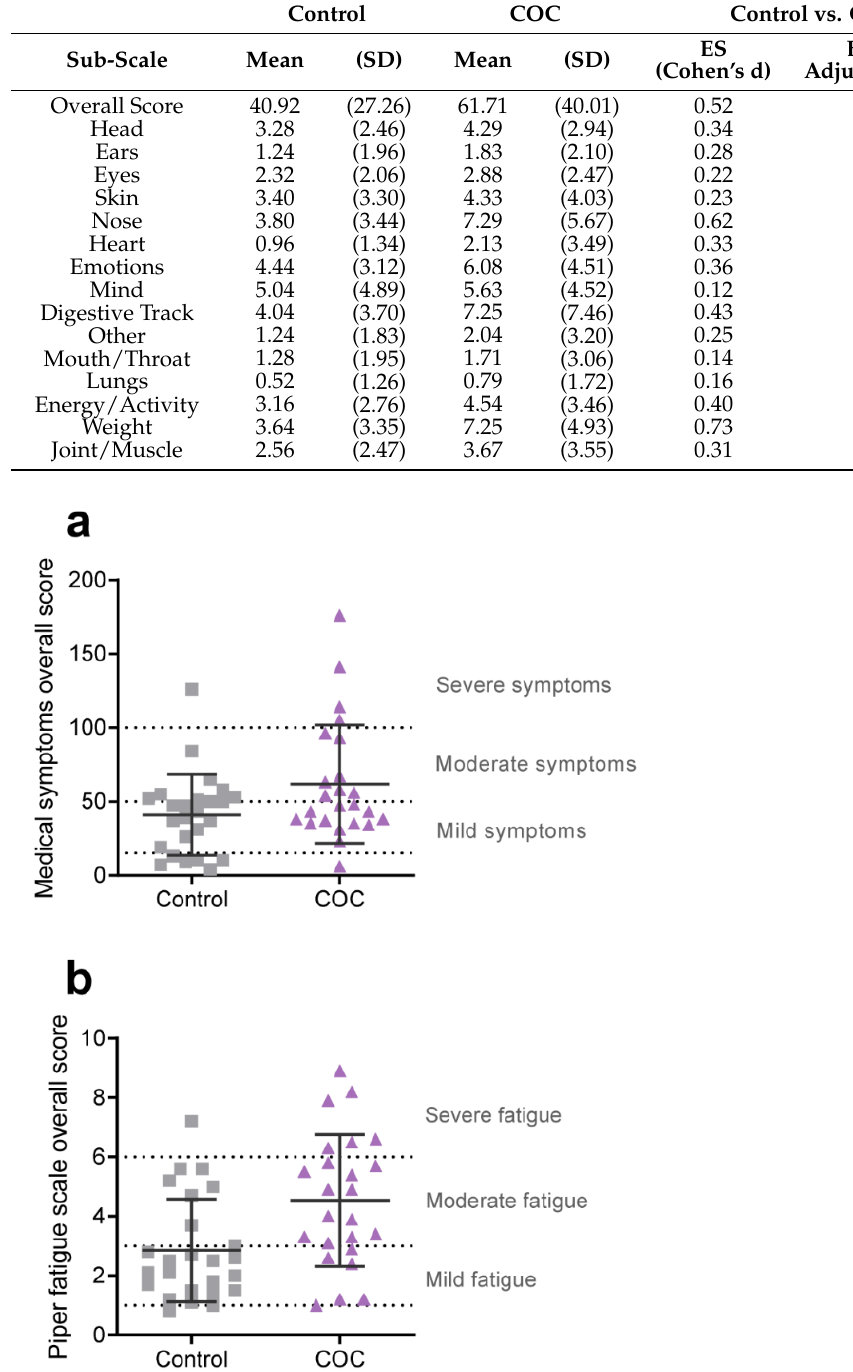
Figure 2. Overall scores for the ( a ) medical symptoms questionnaire and the ( b ) Piper fatigue scale. Dashed lines indicate the cut-off points of the severity levels listed on the right of each graph (as generally applied for the MSQ by physicians affiliated with the Institute for Functional Medicine [38,39] and described in Piper et al. [40] for the PFS). Squares and triangles represent individual controls and COC users, respectively. Horizontal solid lines and error bars indicate means ± SD.